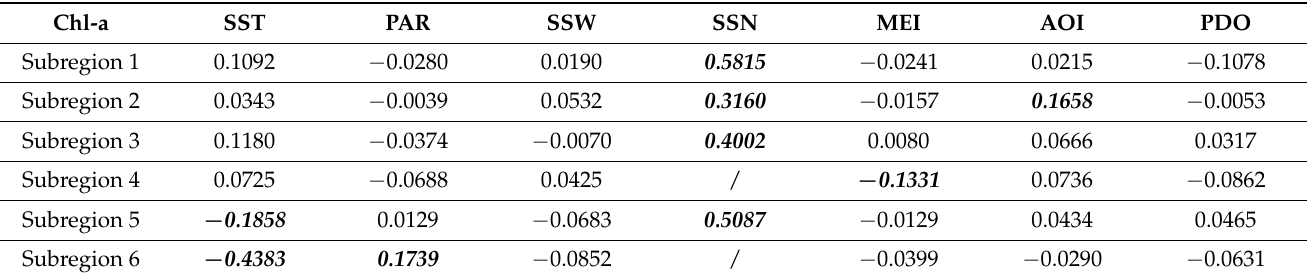
Table 1. Statistics of the correlation coefficient ( R ) between the Chl-a and different environmental variables (i.e., SST, PAR, SSW, and SSN) and climate indices (i.e., MEI, AOI, PDO) in the six